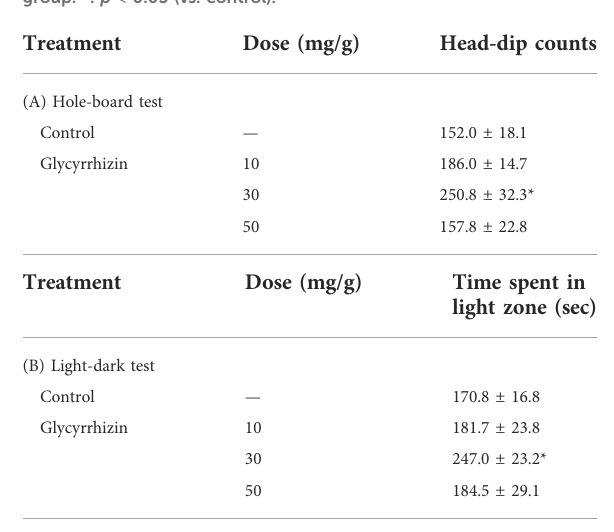
TABLE 1 Results of the light-dark test and the hole-board test. Effect of glycyrrhizin on time spent in the light zone and the number of headdipsincontrolmice,miceadministeredglycyrrhizinfor2 weeks. Data are shown as mean ± standard error of mean (SEM); n = 6 per group. *: p < 0.05 (vs. control).